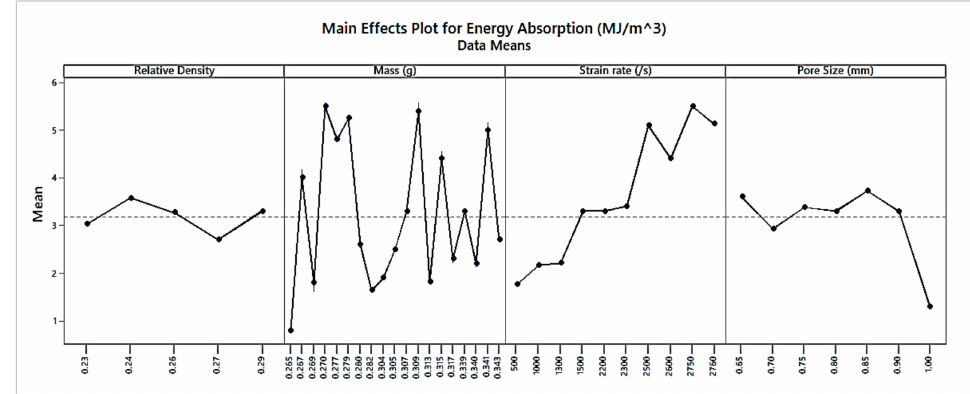
Figure 6. Residual plots obtained for energy absorption from the ANOVA test.